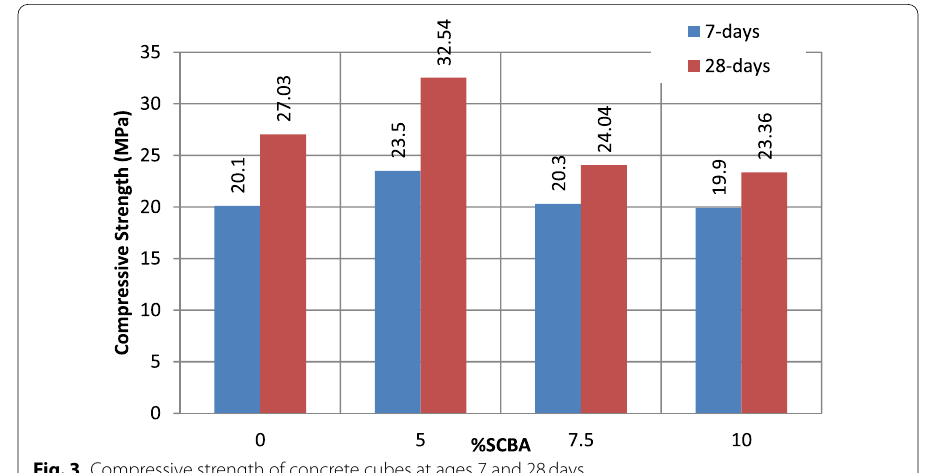
Fig. 3 Compressive strength of concrete cubes at ages 7 and 28 days